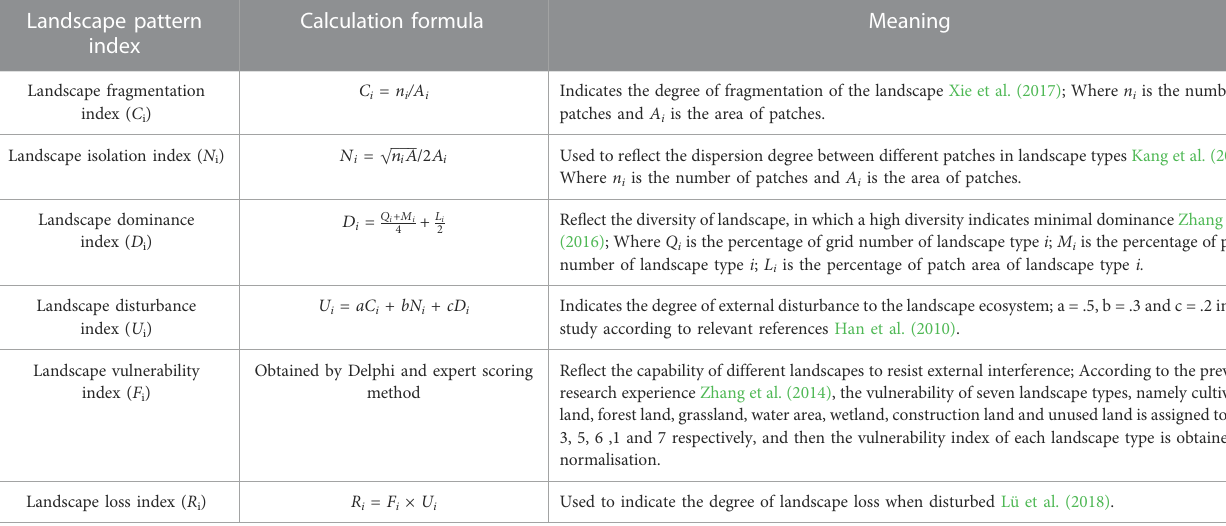
TABLE 2 Interpretation and calculation of landscape pattern index. Landscape pattern